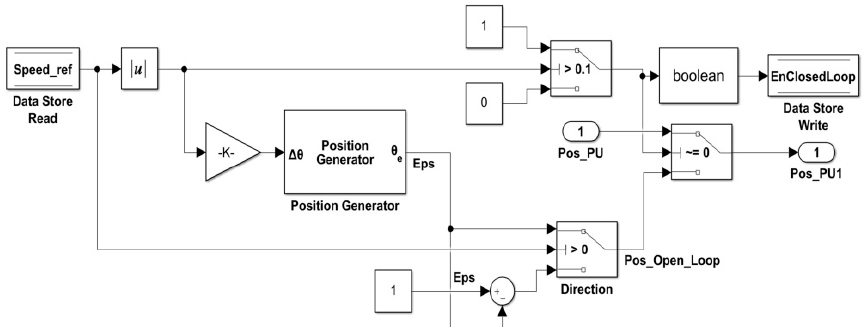
Figure 31. MATLAB/Simulink block diagram subsystem for open loop for real-time implementation—HIL stage.